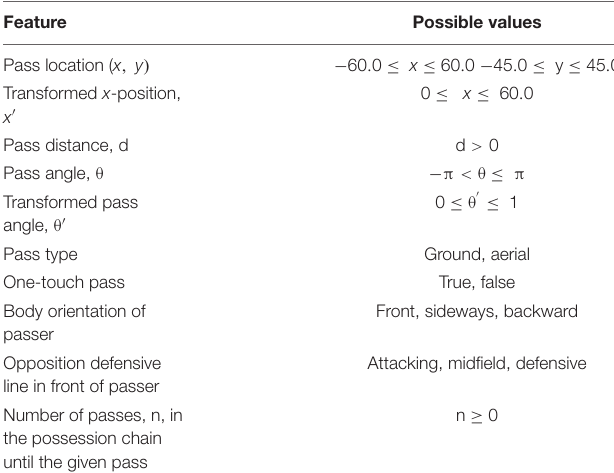
TABLE 1 | Pass difficulty